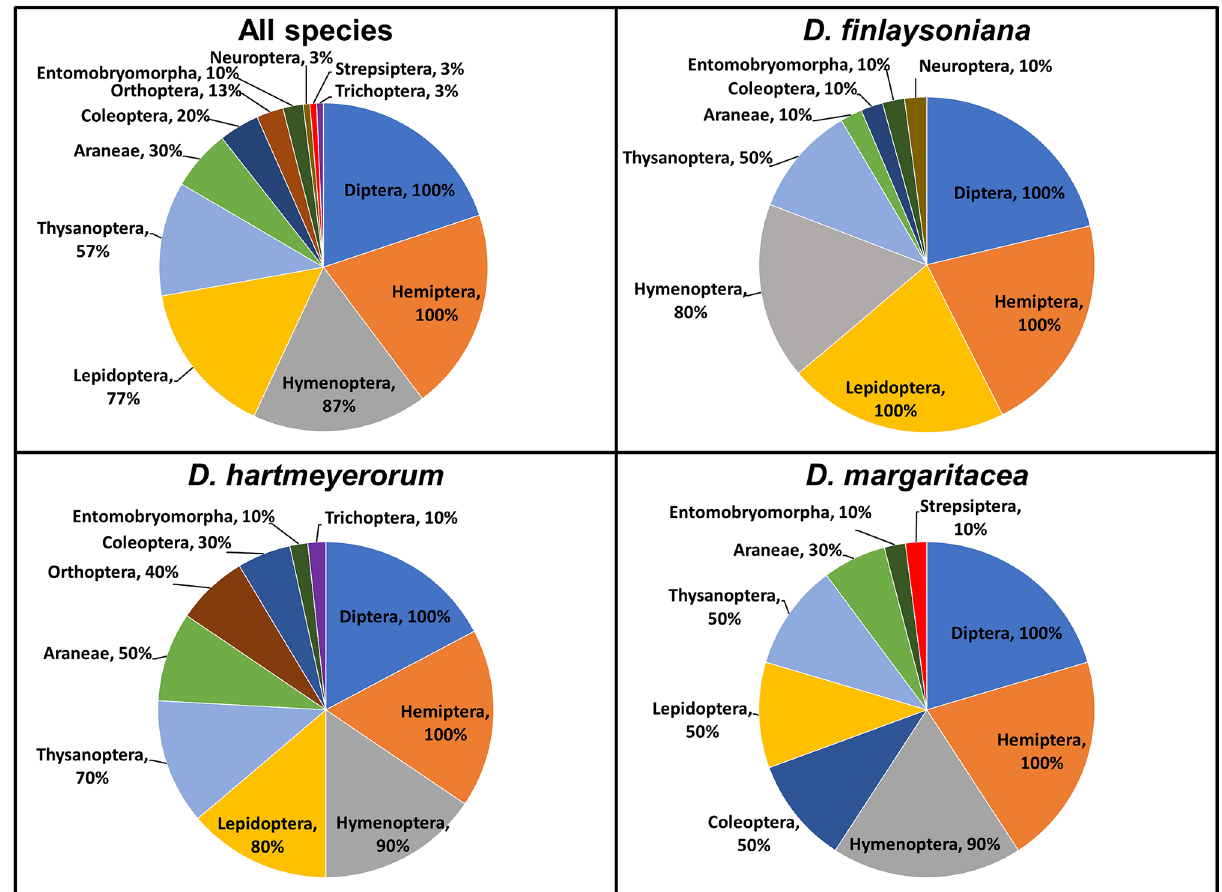
Figure 3. Arthropod orders comprising the prey spectra of three species from Drosera sect. Arachnopus as detected by DNA metabarcoding. The percentage numbers denote the proportion of Drosera samples in which each arthropod order was